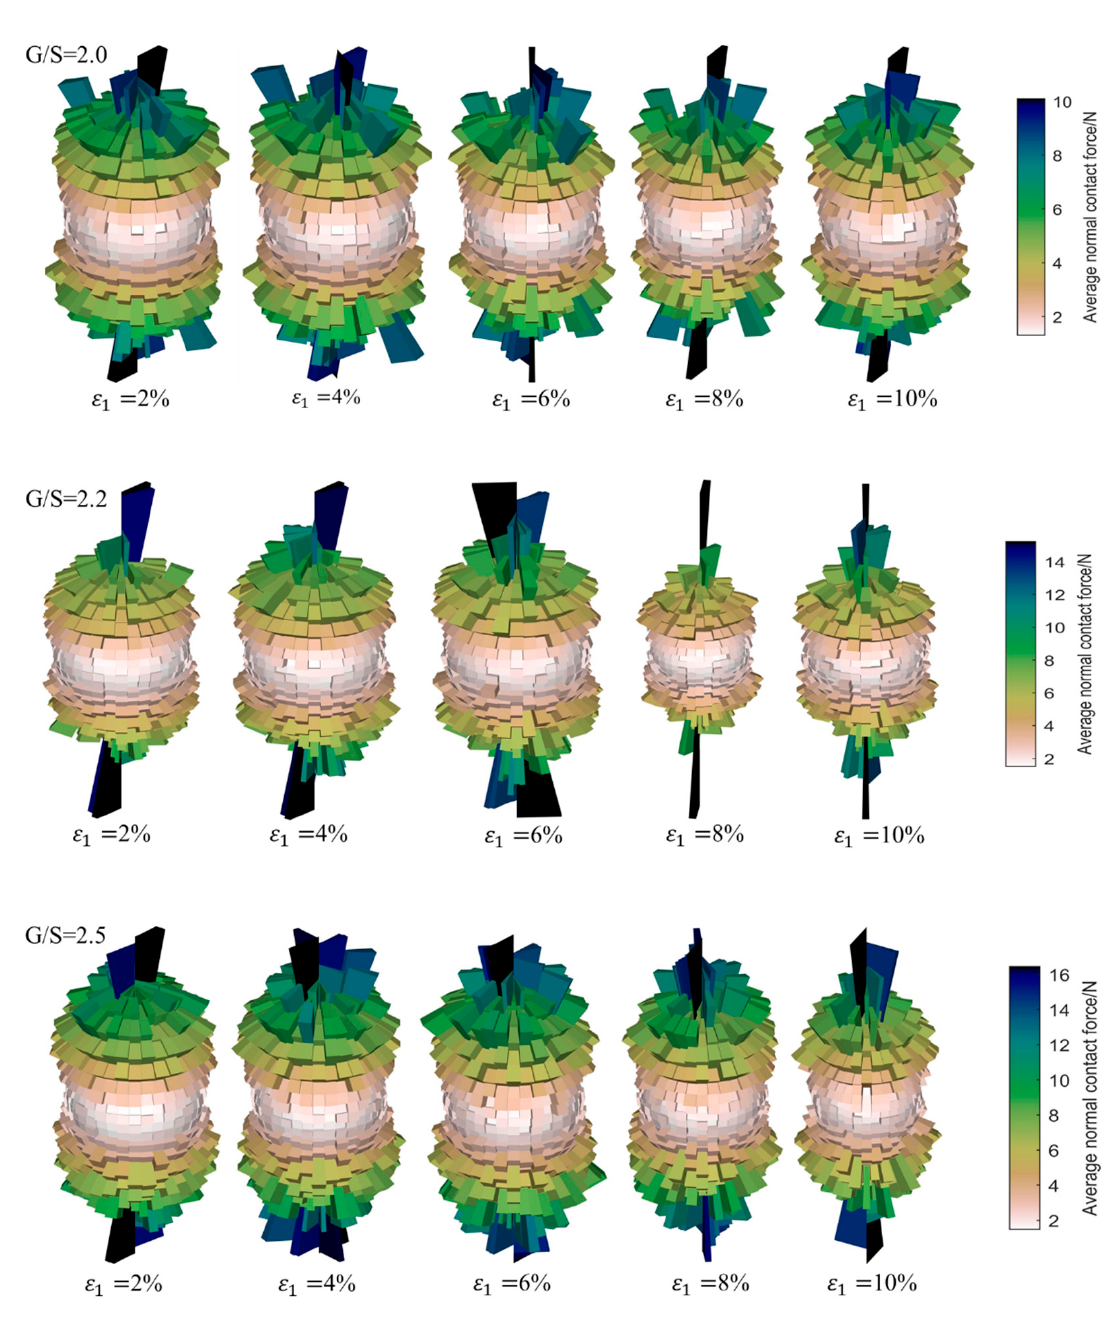
Figure 15. Three-dimensional rose diagrams showing the evolution of normal contact forces during the shearing process for specimens with different G/S values.